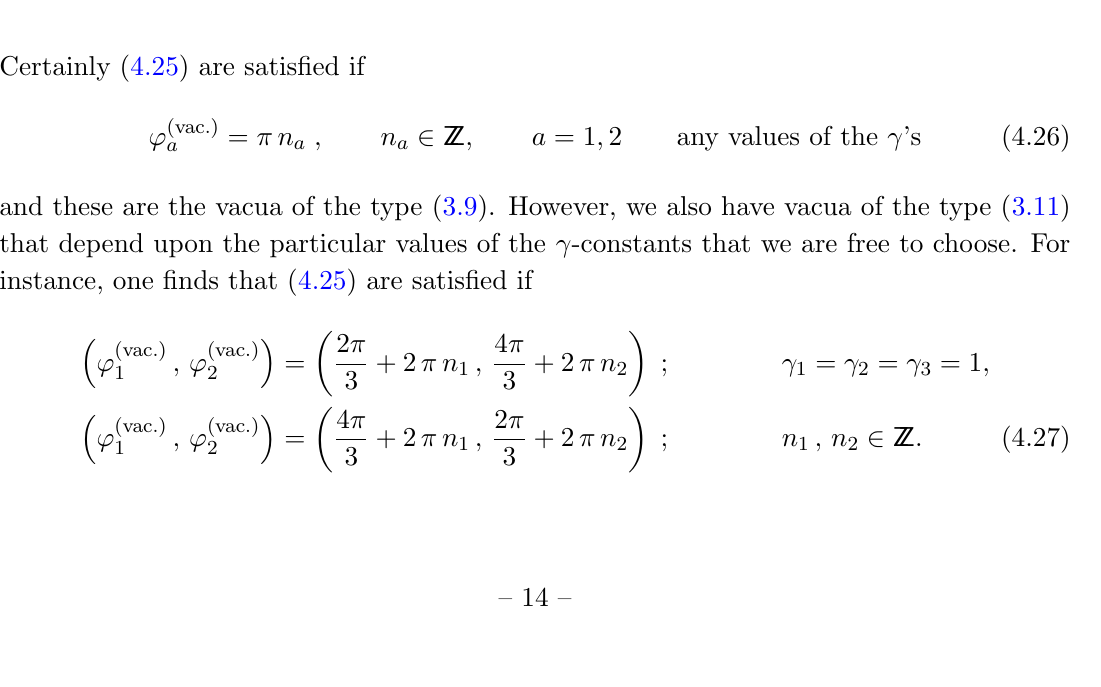
Figure 2 . (a), (c) The pre-potential (4.20) and (b), (d) the potential (4.22). The vacua (4.26) are given by the black dots, (4.27) by (cid:12) and the lines stand for the gradient (cid:13)ow of ~ r U and ~ r V , where ~ r = ( @ 1 and (cid:13) 1 = (cid:13) 2 = (cid:13) 3 = ’ 1 ; @ ’ 2 ). Here (cid:21) = 4